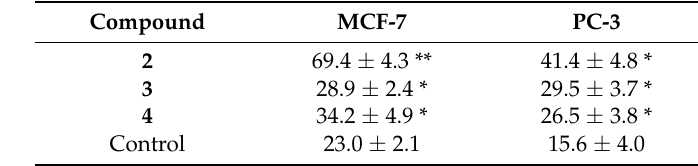
Table 3. Percentage of cells without rhodamine-123 after treatment with compounds 2 – 4 on MCF-7 and PC-3-treated cells.